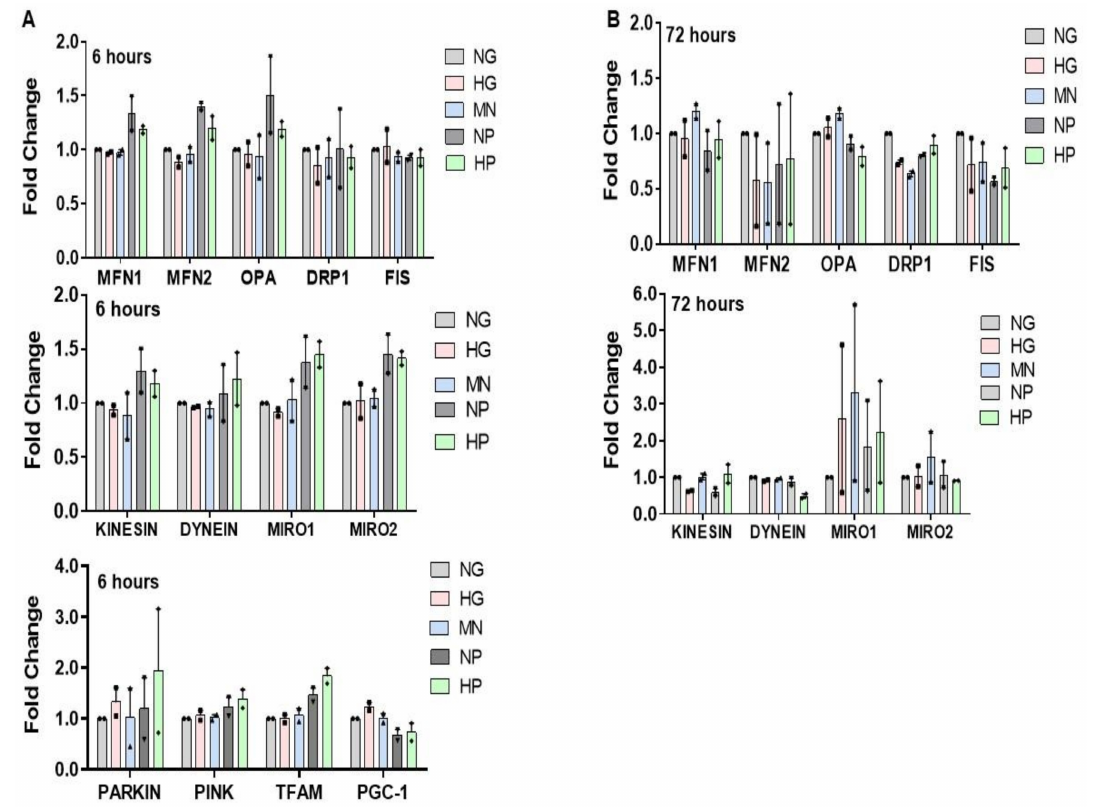
Figure A1. MQCP-genes expression in 6h-GMCs stress-conditioned. ( A ) GMCs stress-conditioned to media during 6h time-point. There was no statistical difference in MQCP-genes expression comparing groups for biogenesis (PGC-1, TFAM), mitophagy (PARKIN, PINK), fusion (MFN1, MFN2, OPA), fission (DRP1, FIS) and motility (KINESIN, DYNEIN, MIRO1, MIRO2) processes ( p > 0.05; n = 2). ( B ) GMCs stress-conditioned to media during 72h time-point. There was no statistical difference in MQCP-genes expression comparing groups for fusion (MFN1, MFN2, OPA), fission (DRP1, FIS) and motility (KINESIN, DYNEIN, MIRO1, MIRO2) processes ( p > 0.05; n =